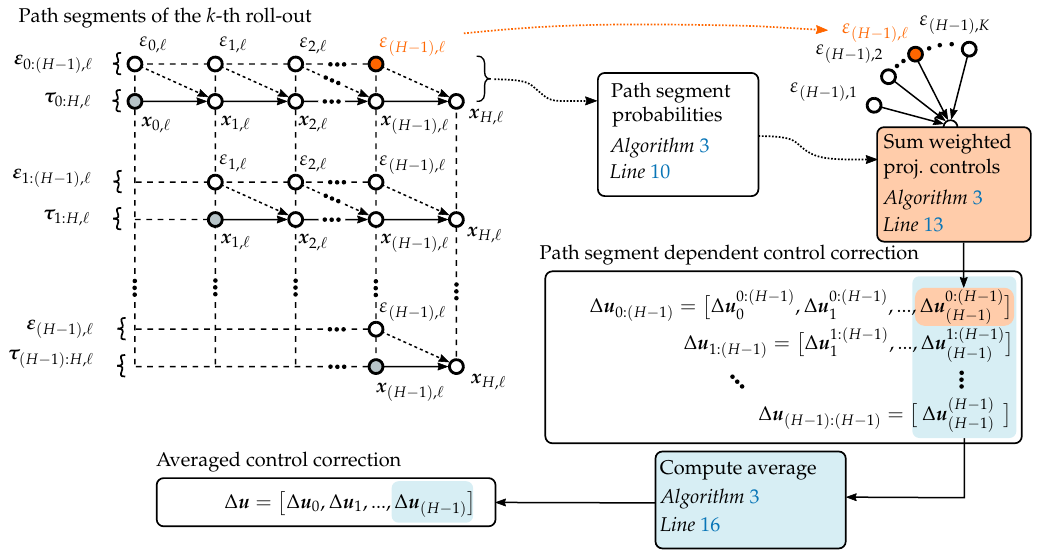
Figure 9. Schematic visualization of the computational steps involved in computing the averaged control correction from K sampled path roll-outs of length H using the PI 2 .